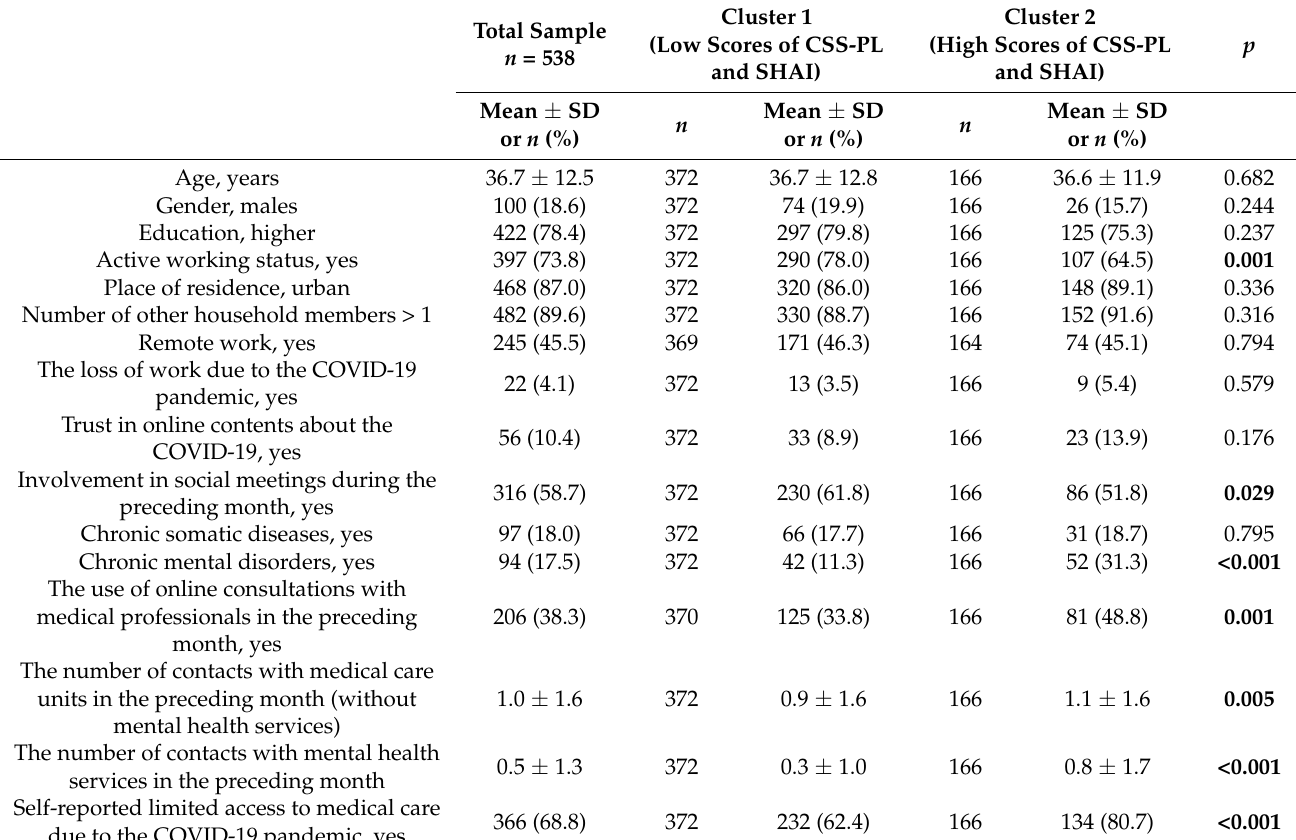
Table 2. General characteristics of the sample with respect to clusters of the CSS and SHAI scores ( n =